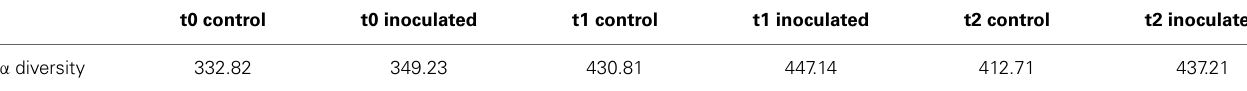
Table 3 | α diversities within the metagenome datasets.